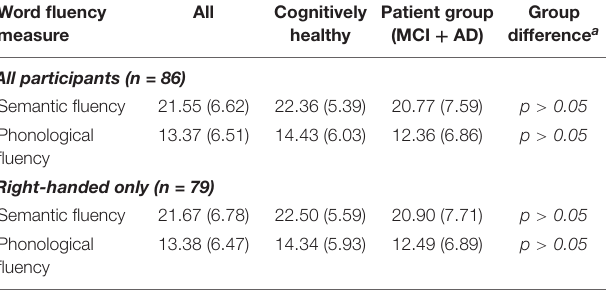
TABLE 2 | Word fluency performances in whole sample and in